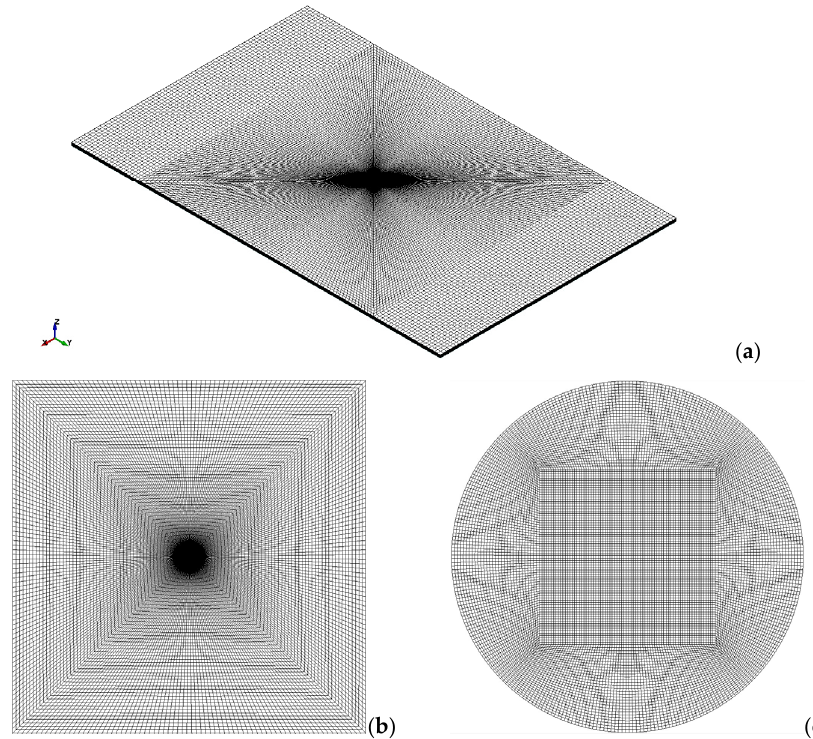
Figure 6. ( a ) FE mesh of the specimen, ( b ) FE mesh of the central square area and ( c ) FE mesh of the circular area under the laser spot [9].